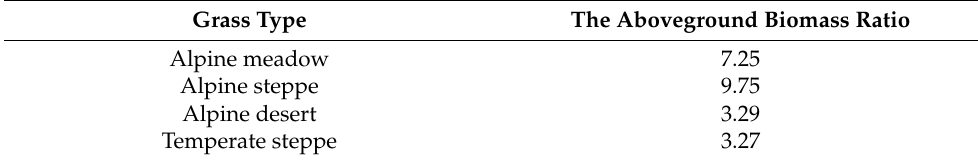
Table 2. The aboveground biomass ratio of different grassland types in the TRHR. Grass Type The Aboveground Biomass